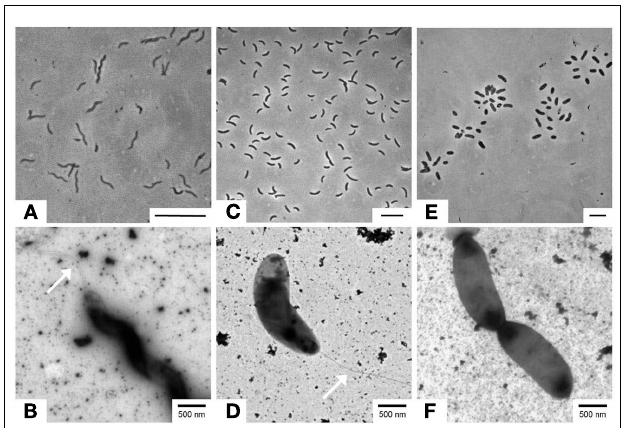
FIGURE 2 | Microscopic images from three sulfate-reducing isolates obtained from sediments of IODP Site U1301. (A,B) Desulfovibrio aespoeensis strain P20 (1.3mbsf); (C,D) Desulfovibrio indonesiensis strain P23 (260.4mbsf); (E,F) Desulfotignum balticum strain P18 (260.4mbsf). Upper images: phase contrast (bar = 5 μ m); lower images: transmission-electron microscopy,TEM (bar = 500nm). Arrows in (B,D) indicate